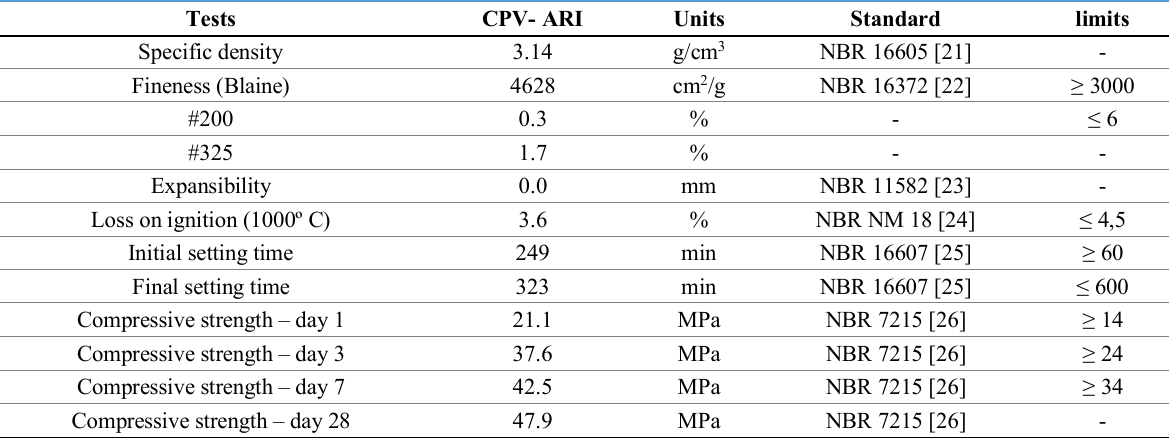
Table 2. Physical and mechanical characterization of cement